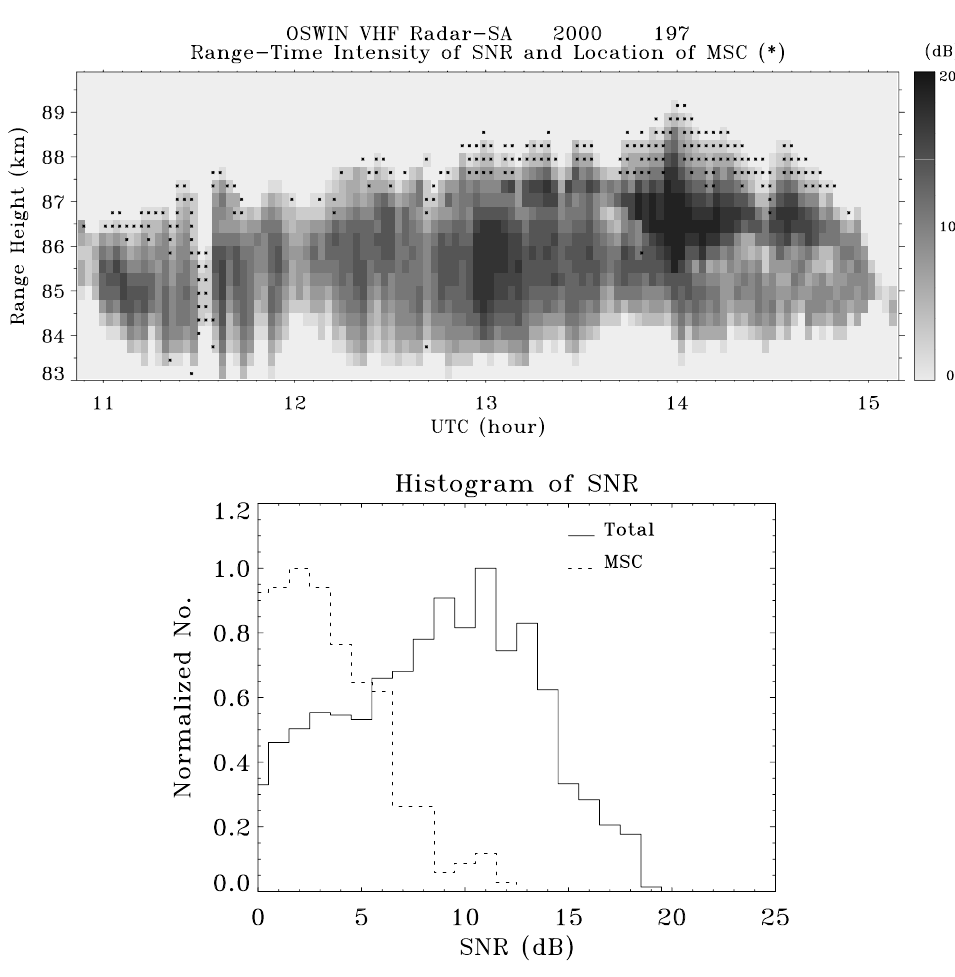
Fig. 4. Same as Fig. 3, but with a 16-s time resolution (1024